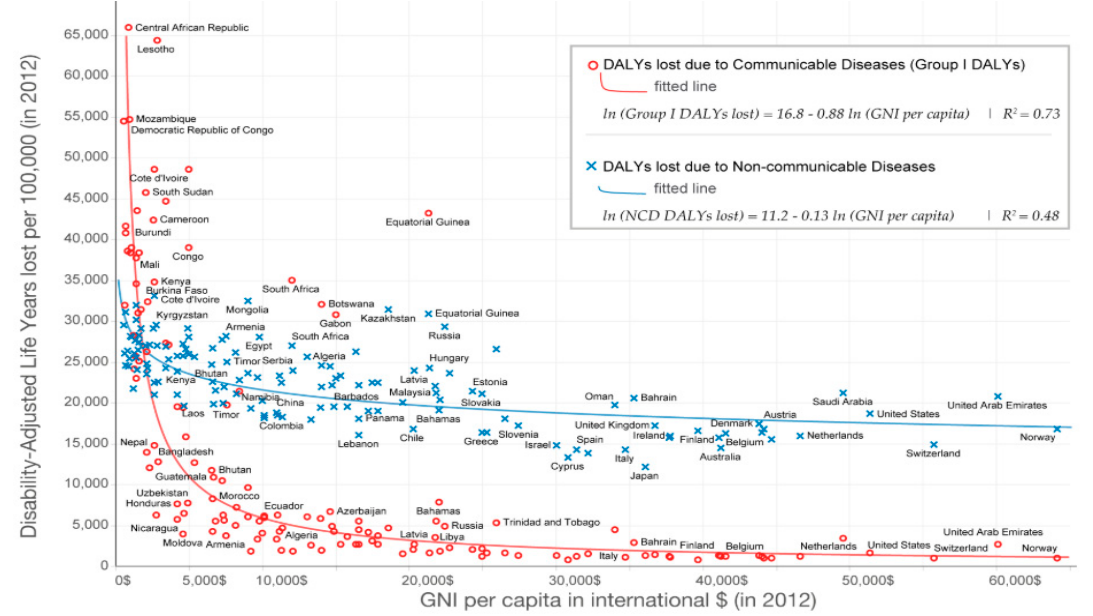
Figure 19. Total disease burden in the world in 2017, measured using the value disability-adjusted life years (DALYs) on millions. One DALY equals to one lost year of healthy life. Information provided by M. Roser and H. Ritchie, “Causes of Death”. Published online at OurWorldInData [87].